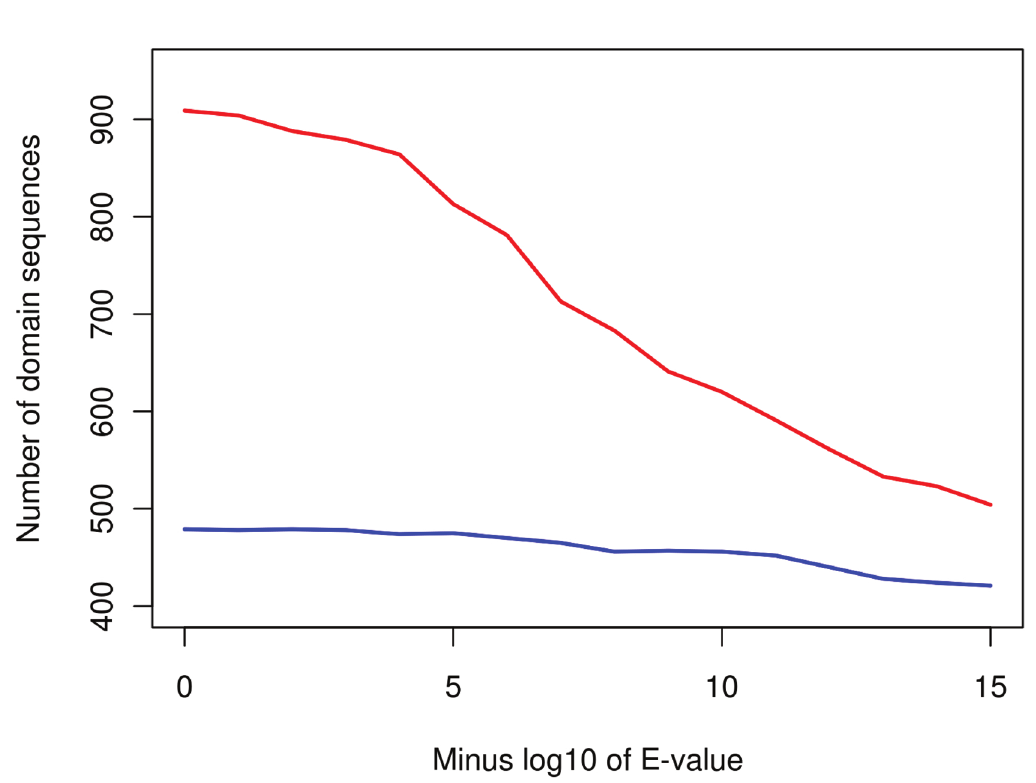
of the HMMER3 E-value cutoff and goes from E = 10 -0 on the left to 10